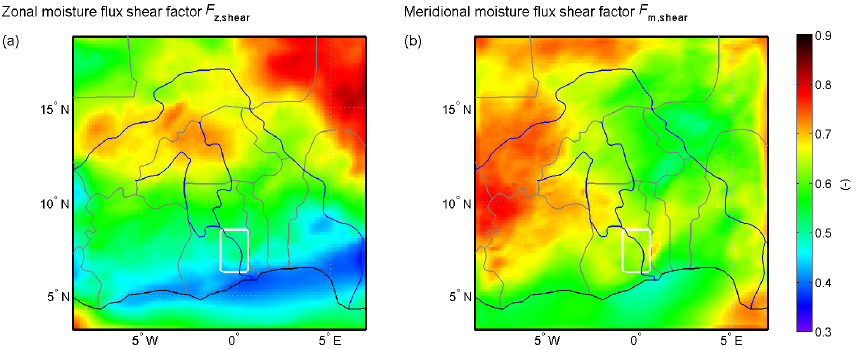
Fig. 10. Horizontal moisture flux shear factors as defined by Eqs. (7) and (8) averaged over August 1998 according to the MM5 model run. (a) Zonal moisture flux shear factor, and (b) meridional moisture flux shear factor. The lower the value the more sheared the moisture flux.